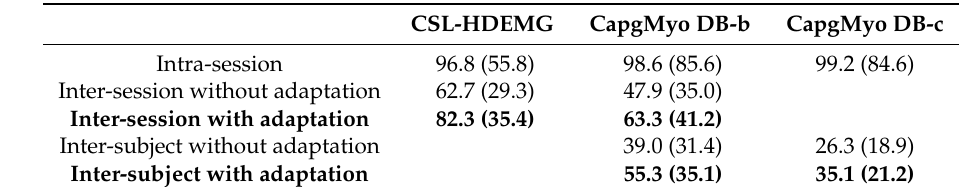
Table 4. Recognition accuracies (%) of different evaluation protocols on CSL-HDEMG (27 gestures) and CapgMyo (8 gestures for DB-b and 12 gestures for DB-c). The numbers are majority voted results using entire trial for CSL-HDEMG and 150 ms window (i.e., 150 frames) for CapgMyo, respectively. Per-frame accuracies are shown in